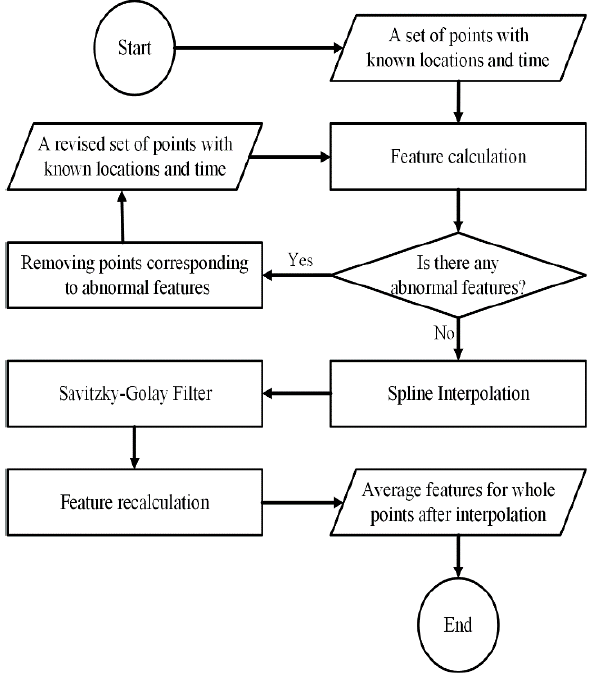
Figure 2 . Flowchart of feature extraction and noise removal